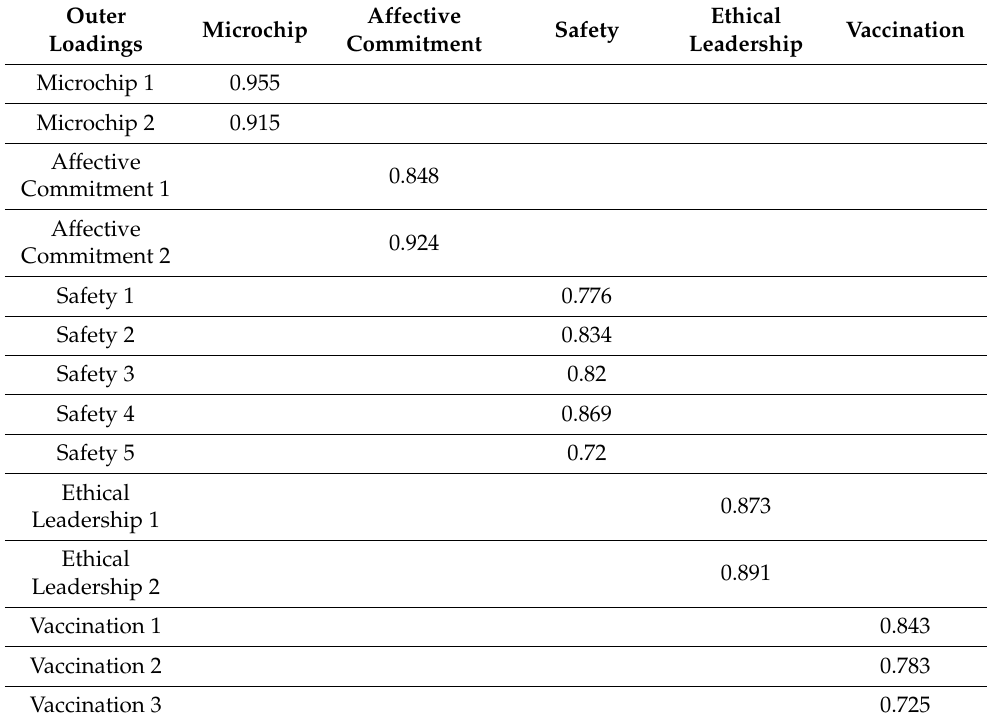
Table 4. Outer Loading Testing